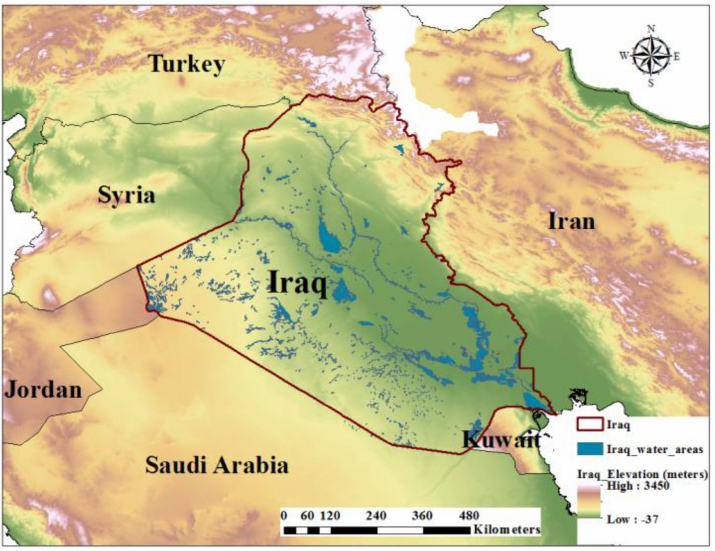
Figure 1. Elevation map of Iraq and neighboring countries (source: